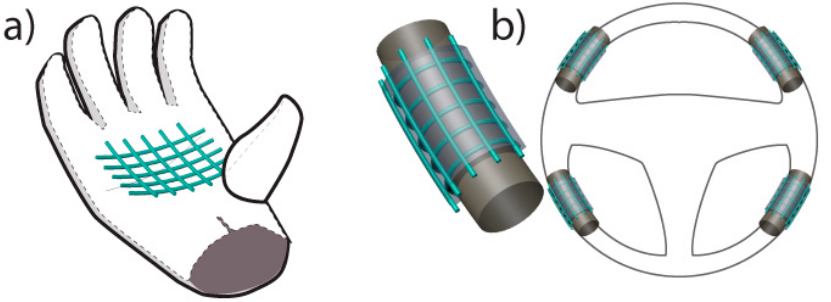
Figure 1. Example of a body-worn pressure sensor ( a ) vs. a vehicle surface pressure sensor ( b ).